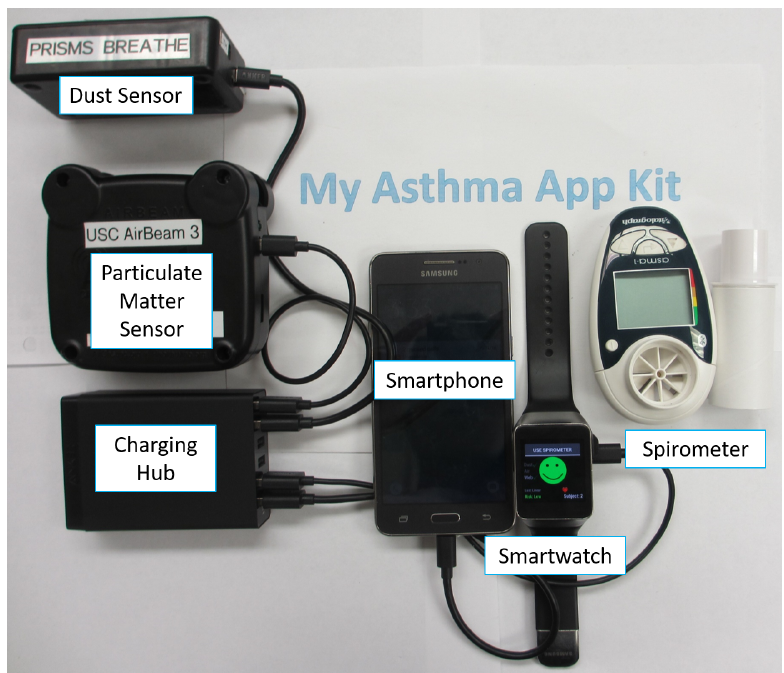
Figure 1. My Asthma App Kit given to individuals for real-time asthma risk